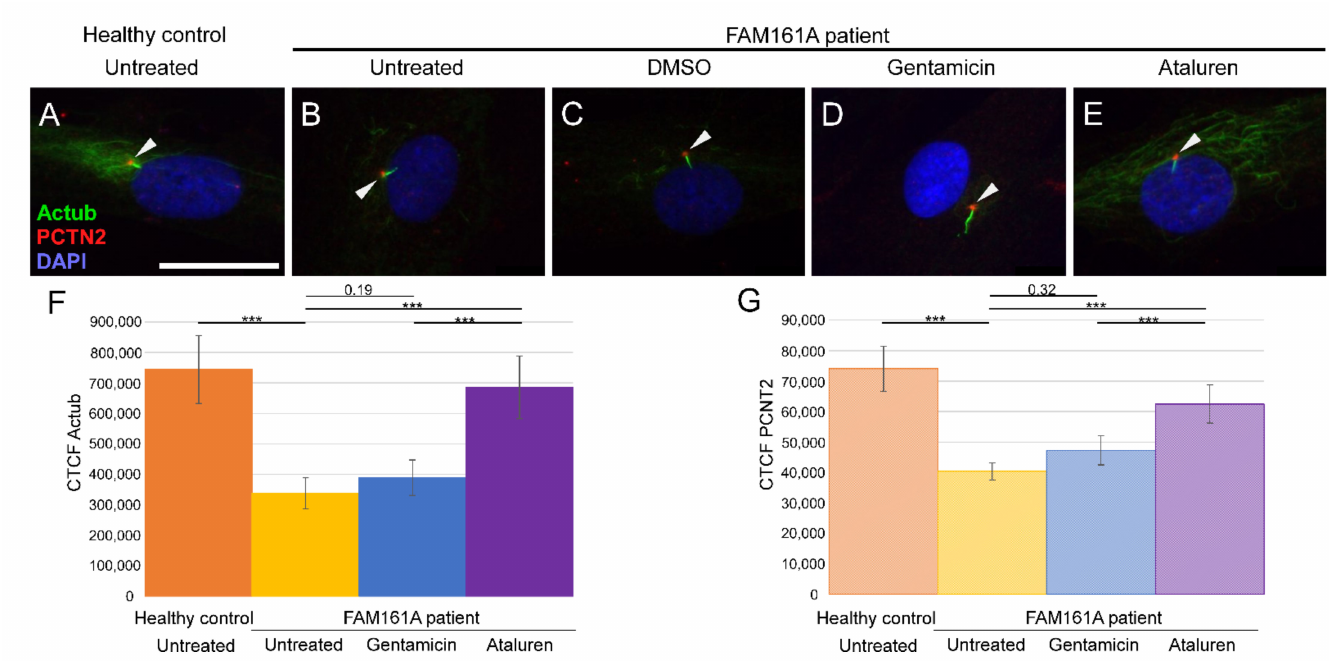
Figure 2. Ciliogenesis in fibroblast cells of FAM161A patients following TRID treatment. Im- munofluorescence analysis of fibroblast cells from healthy controls ( A ) and FAM161A patient cells ( B – E ) after triggering ciliogenesis by starvation for 48 h. Antibodies against acetylated tubulin (Actub, green) marker for cilia, pericentrin (PCTN2, red) stains the basal body, and nuclei are stained by DAPI (blue). Cilia are marked with white arrows. FAM161A patient cells were left untreated ( B ), or treated with DMSO as control ( C ), Gentamicin ( D ) or Ataluren ( E ). Scale bar 25 µ m. ( F , G ) Quantification of Actub ( F ) and PCNT2 ( G ) expression levels in fibroblasts. Fluores- cence intensities of Actub and PCNT2 in healthy untreated cells (orange) and untreated (yellow) Gentamicin-treated (blue) and Ataluren-treated (purple) cells from patients were measured using ImageJ, and the corrected total cell fluorescence (CTCF) was calculated (arbitrary units). The significance levels were set when p < 0.001